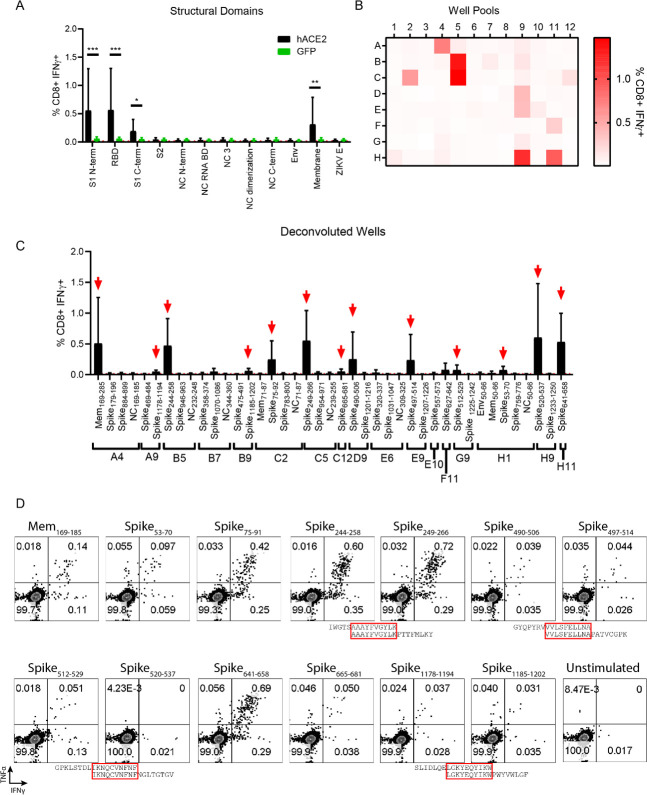
In vivo transfection of hACE2 mRNA permits the detection and functional mapping of SARS-CoV-2 specific CD8+ T cell responses.(A) CD8+ T cell responses to pooled peptide domains. Each equimolar peptide library pools was demarcated by peptides contained in functional domains of each protein (11 total pools). Five days post boosted infection with SARS-CoV-2 following mRNA transfection harvested splenocytes were stimulated with each peptide pool. Cells were stained to evaluate the frequency of responsive CD8+ T cells by IFN-γ expression. (B) CD8+ T cell responses to smaller well peptide pools. Each library was incorporated into multiple 96-well plate formats (S5 Fig). Within the same layout, wells from the plates were pooled such that all A1 peptides were pooled, all A2 peptides, etc. maintaining the 96-well plate format reducing the overall number of screened samples. As in 3A splenocytes boosted mice were harvested and stimulated with each peptide pool. The frequency of IFN-γ+ CD8+T cells—the magnitude of which represents responsiveness to a peptide in the pool, is enumerated in a heat map format as the average responses of 3 mice. (C) Identified potential well hits, were deconvoluted and used individually to stimulate splenocytes from hACE2 transfected, SARS-CoV-2 infected mice. 13 potential epitopes were identified (marked with red arrows) as defined by the frequency of IFN-γ+ CD8+T cells being at least 2-fold above background (stimulated with vehicle) in at least 3 of the 4 mice screened. (D) Representative flow cytometry plots displaying IFN-γ and TNFα expression in CD8+ T cells for each putative epitope in comparison to a vehicle control. Due to the overlapping nature of the peptide library, Spike244-258 and Spike249-266, likely are demonstrating responsiveness to the same peptide epitope. 3 other instances of this phenomenon are denoted with red boxes surrounding the amino acid sequence overlap. Statistical significance was determined by Mann-Whitney test (*p = .0159, **p = 0.0079).